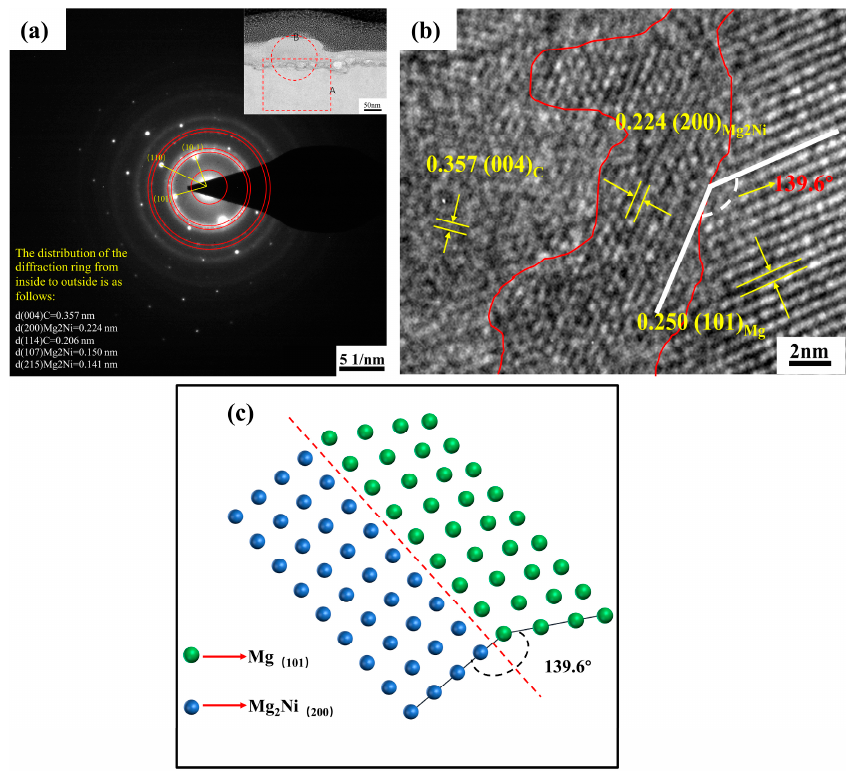
Figure 8. Electron diffraction pattern and interface structure of composite materials ( a ) electron dif- fraction pattern of region B; ( b ) Interface structure diagram of CNTs, Mg, and Mg 2 Ni (region A); ( c ) Schematic diagram of common lattice interface.